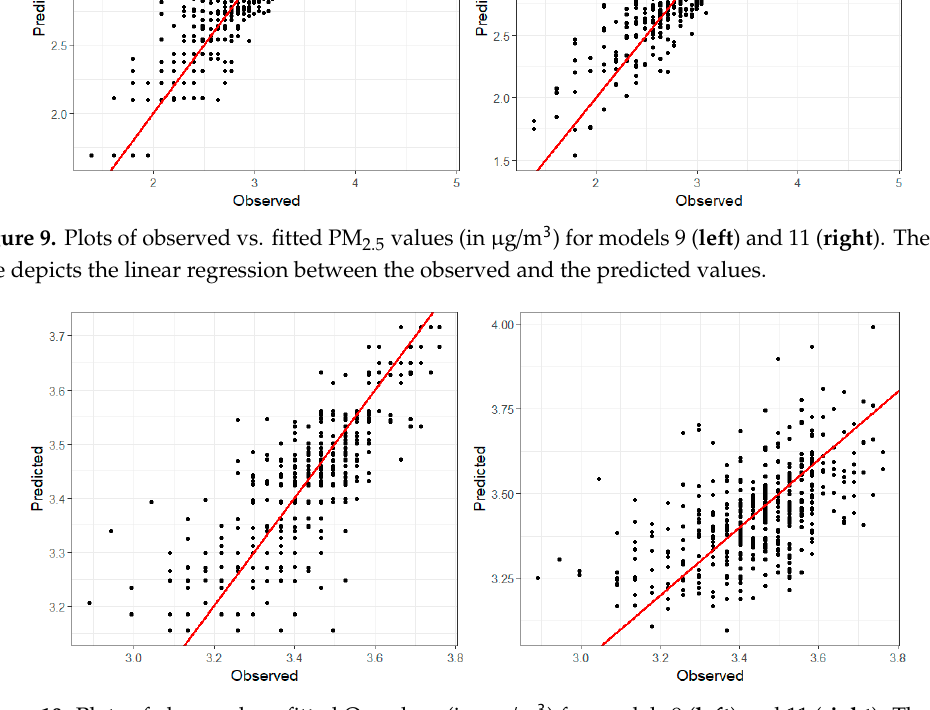
Figure 10. Plots of observed vs. fitted O 3 values (in mg/m 3 ) for models 9 ( left ) and 11 ( right ). The red line depicts the linear regression between the observed and the predicted